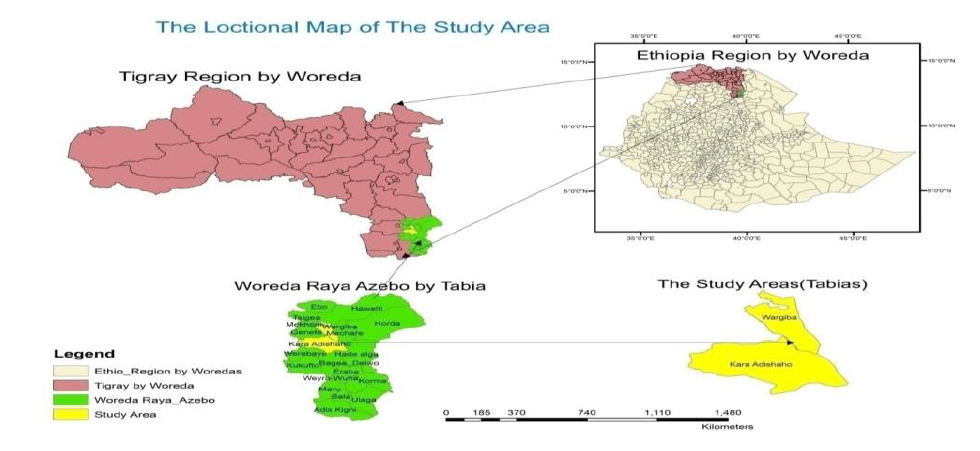
Figure 1: Map of the study